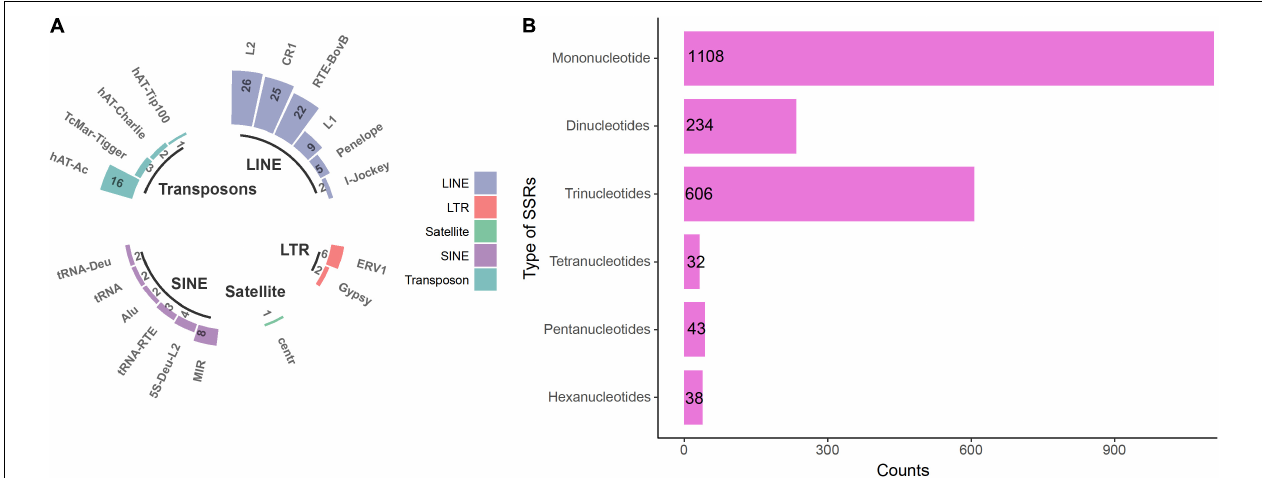
FIGURE 1 | Repetitive sequences in the genome of Ceriporia lacerata . (A) Repeat region types and counts identified by RepeatMasker. (B) SSRs identified by MISA. LINE, long interspersed nuclear element; LTR, long terminal repeat; SINE, short interspersed nuclear element.